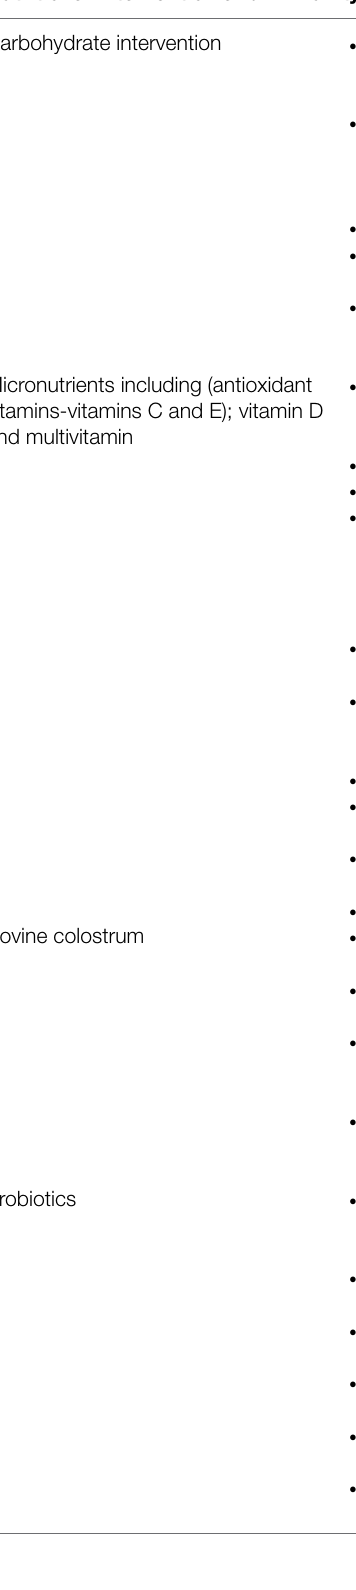
TABLE 1 | Common nutritional intervention and key food involved to stimulate human immune system. Nutritional intervention and immunity Carbohydrate